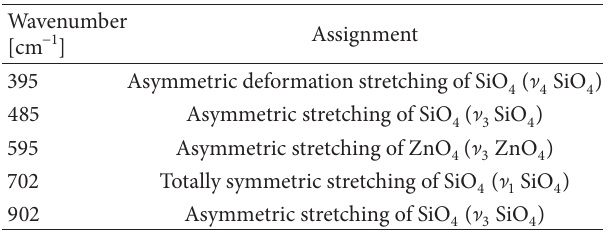
Table 1: FTIR transmission features and their assignments for oxide